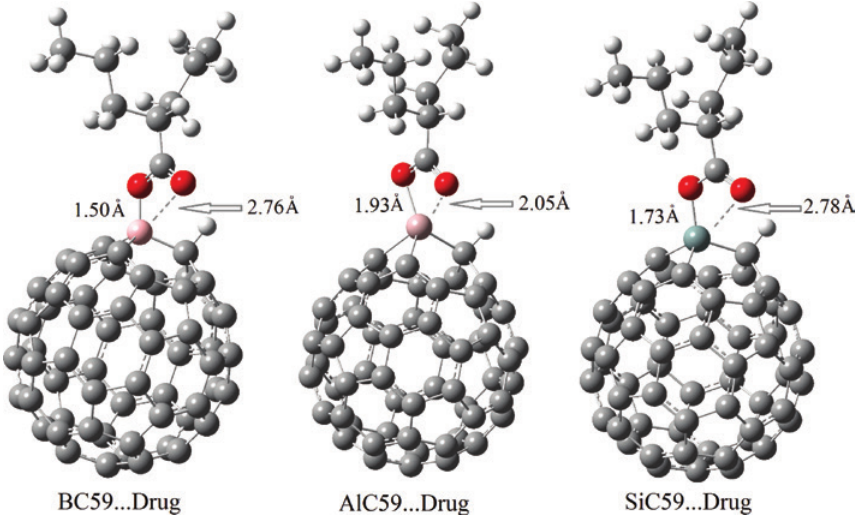
Figure 1: Optimized structures of the